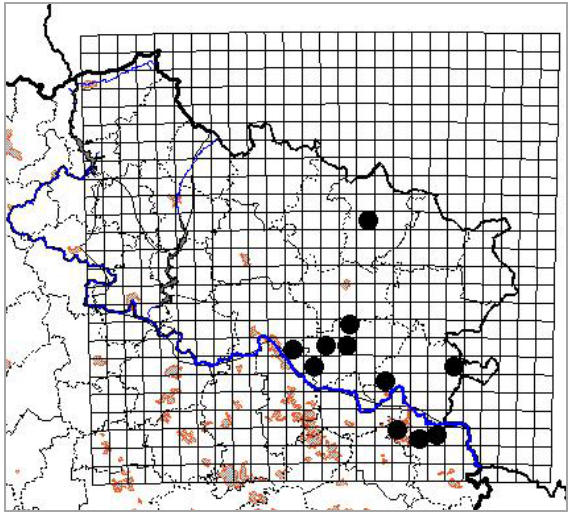
Fig. 19. The map of the distribution of Elaeagnus angustifolia L. in the Starobilsk grass-meadow